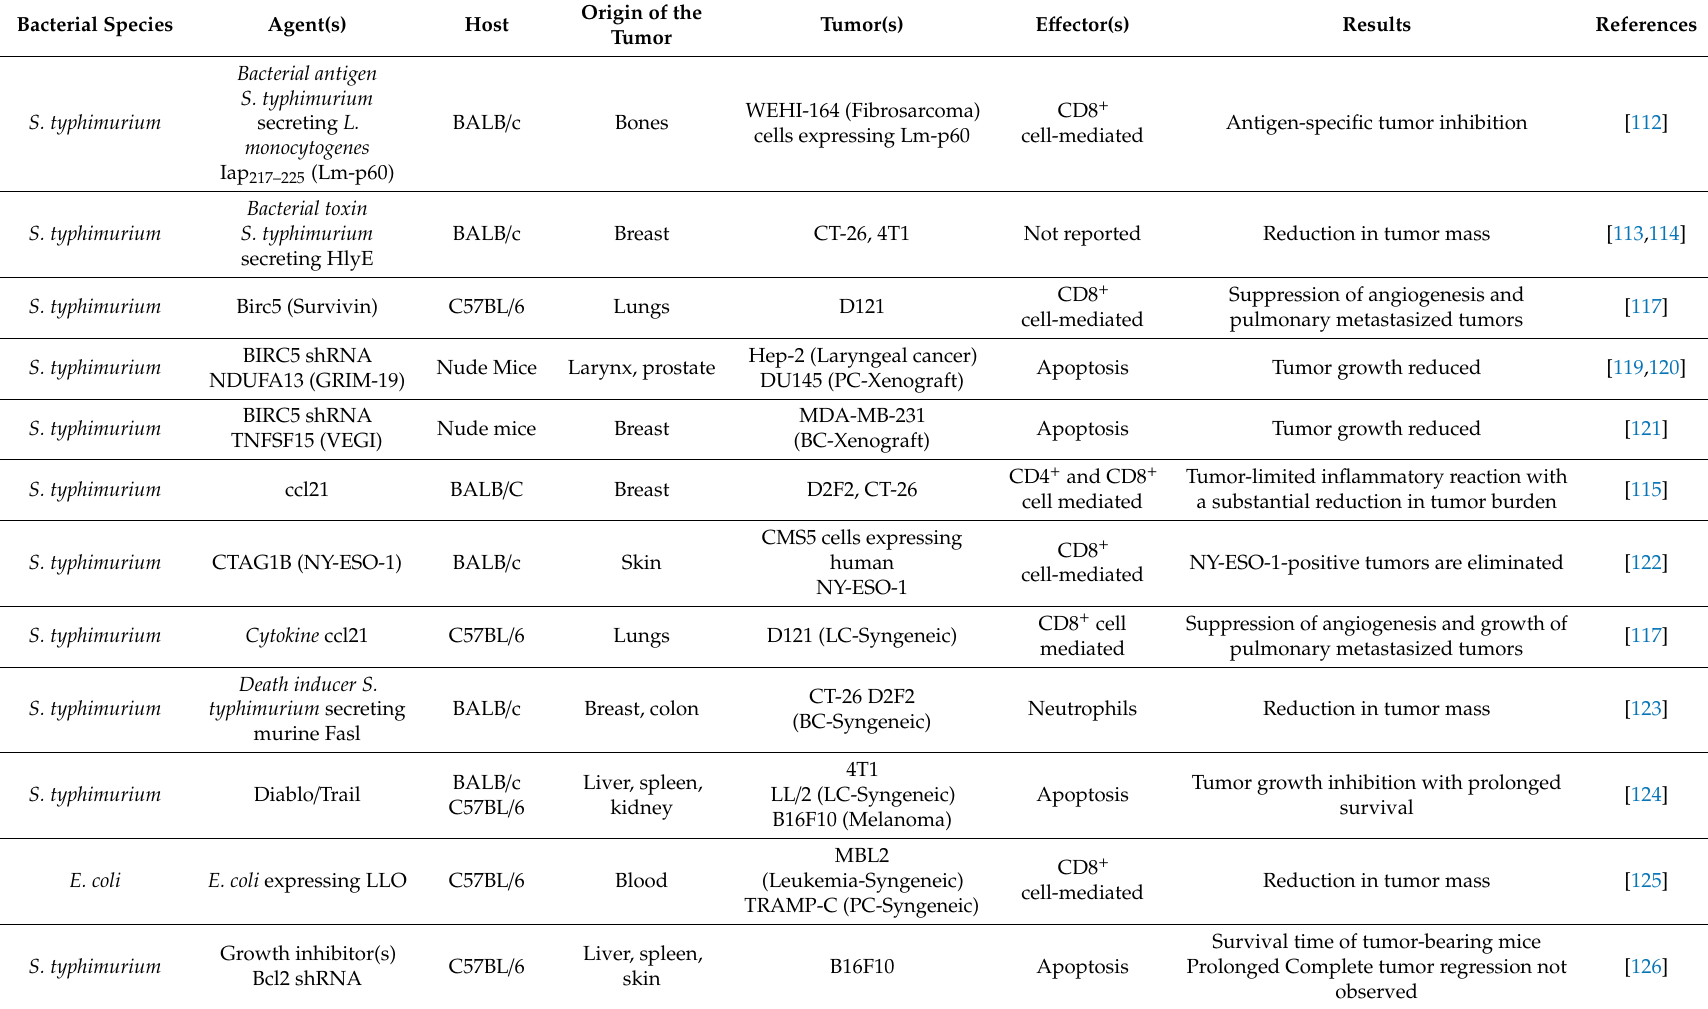
Table 2. Programmed bacteria expressed as anti-tumor agents in various animal